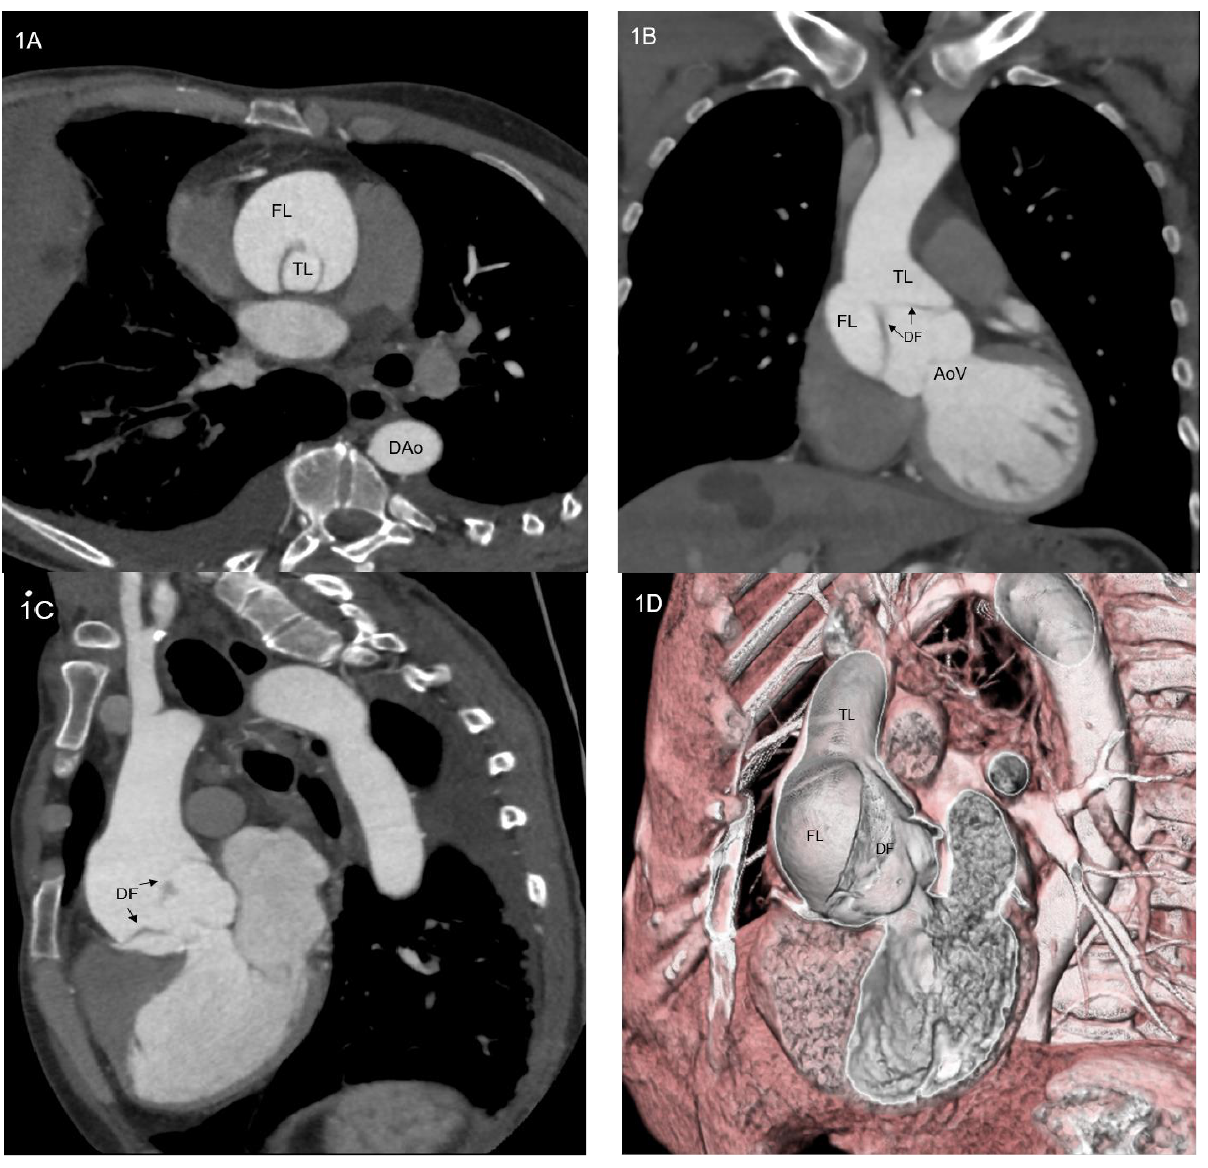
Figure 1. ( A – D ) Computed tomography angiogram of a patient with type A aortic dissection: axial scan ( A ), coronal scan ( B ), sagittal scan ( C ) and 3D volume rendering view. AoV = aortic valve; DAo = descending aorta; DF = dissection flap; FL = false lumen; TL = true lumen.